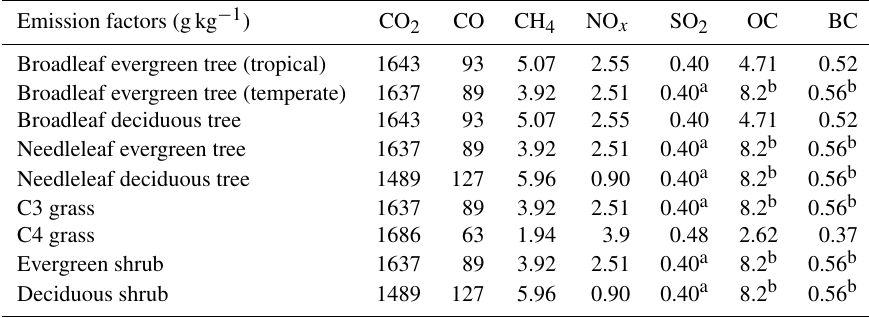
Table 1. INFERNO’s emission factors per PFT created from the emission profiles in Akagi et al. (2011), such that each PFT was attributed a fire biome (see Table A1). This method of attributing emission factors to PFTs is similar to that presented in Thonicke et al. (2010), and can be extended to include all species of trace gases and aerosols compiled in Akagi et al.